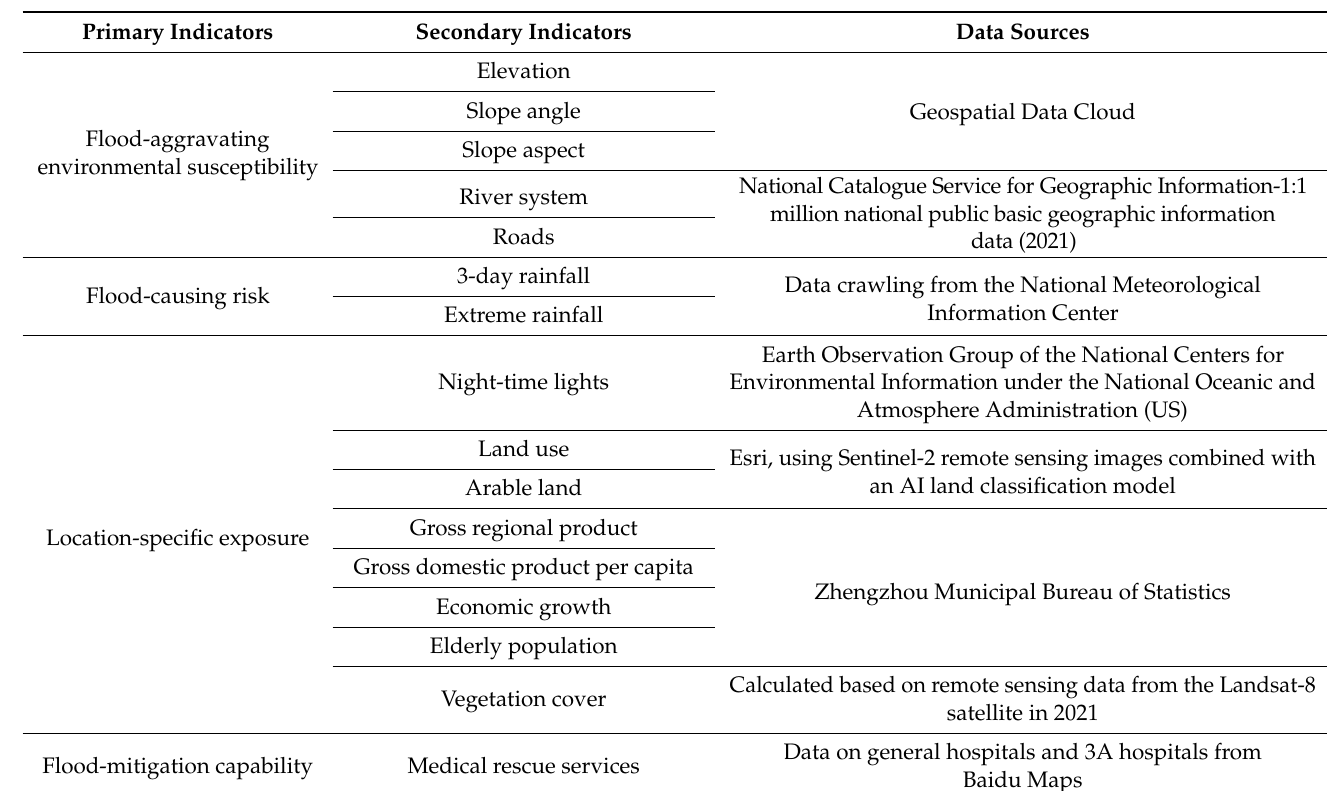
Table 1. Data sources of all